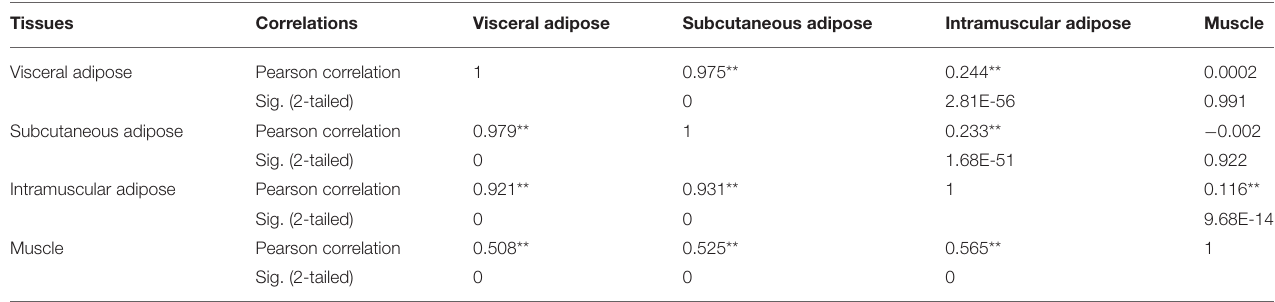
TABLE 2 | Correlation of the gene expression levels in four